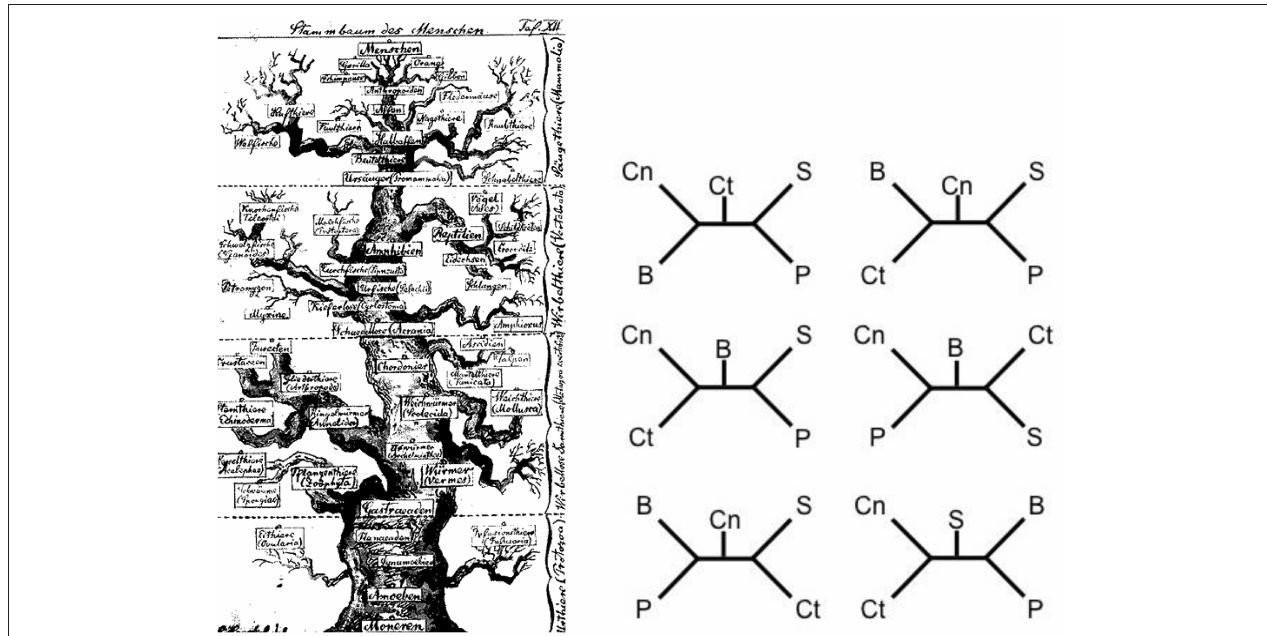
FIGURE 1 | One of the first evolutionary scenarios for the animal tree of life (on the left; Haeckel, 1874) and some current “hypotheses” for the relationships at the base of the metazoan tree of life (on the right; from Schierwater et al., 2009). In the very early days the first metazoan branch harbors the sponges and coelenterates, so do some scenarios on the right. The main difference being that Haeckel drew a very natural looking tree to highlight the speculative nature of the relationships while the modern trees are drawn as distinct linear branching patterns. In the latter the speculative nature often only becomes visible if different trees from different studies are compared, as shown in six examples on the right. Remarkably, all shown scenarios can claim high support values between 90 and 100% for the critical branches. Cn, Cnidaria; Ct, Ctenophora; S, Sponges; P, Placozoa; B,